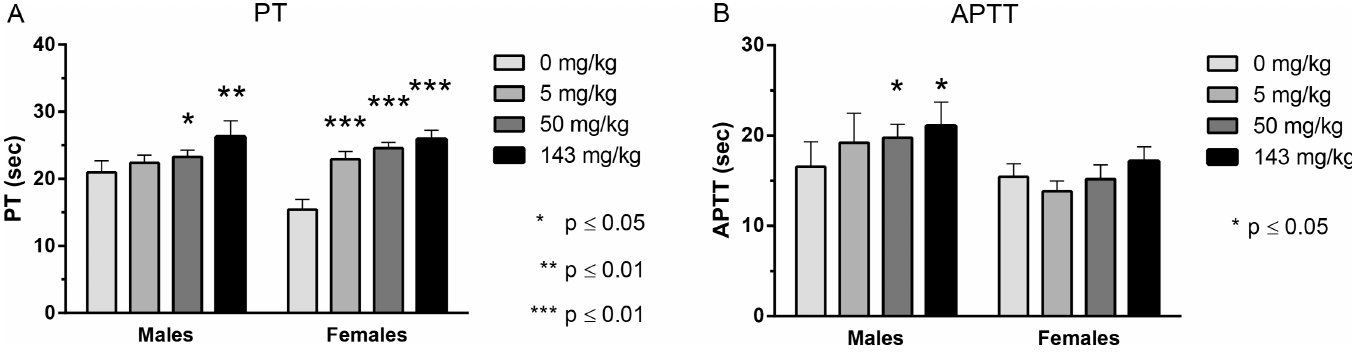
Fig 2. Effect of HSA-NEPv on PT and APTT in rats. Mean ( ± SD) PT (A) and APTT (B) in rats after twice weekly administration of HSA-NEPv at dose levels of 0 (vehicle control), 5, 50 or 143 mg/kg for 1 month (n = 5 animals/gender/group). PT and APTT were measured on Day 26 (the day after the eighth dose). * P < 0.05; ** P < 0.01 compared with